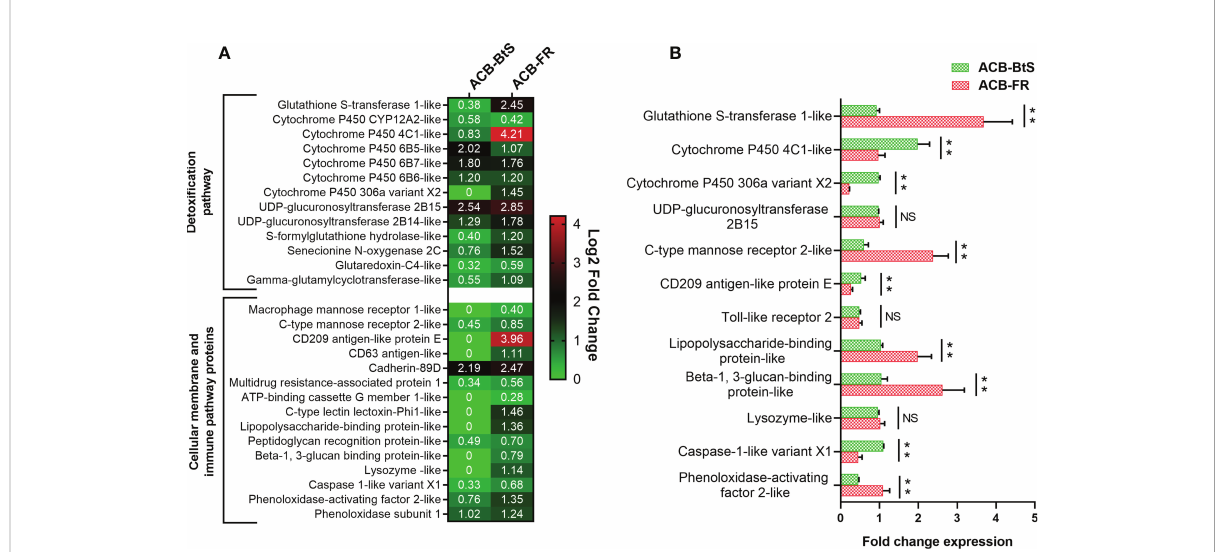
FIGURE 2 Analysis of differentially expressed genes encoding membrane and immune/detoxi fi cation proteins in hemocytes after Cry1F treatment in susceptible (ACB-BtS) and Cry1F-resistant (ACB-FR) strains of Asian corn borer. (A) Differentially expressed genes (DEGs) and fold change compared with respective controls (Student ’ s t-test, P <0.05). The numbers in the heat map represent the log2 fold change in gene expression, a value of 0 indicates that the gene was not detected in the DEGs or down-regulated lists. (B) Difference (fold change) in expression levels (mean ± standard error) of genes involved in detoxi fi cation and immune pathways of hemocytes from the ACB-BtS and ACB-FR strains after Cry1F treatment (LC50 dose). Asterisks denote that differences in gene expression were statistically signi fi cant (Student ’ s t-test, ** P <0.01, NS, not signi fi